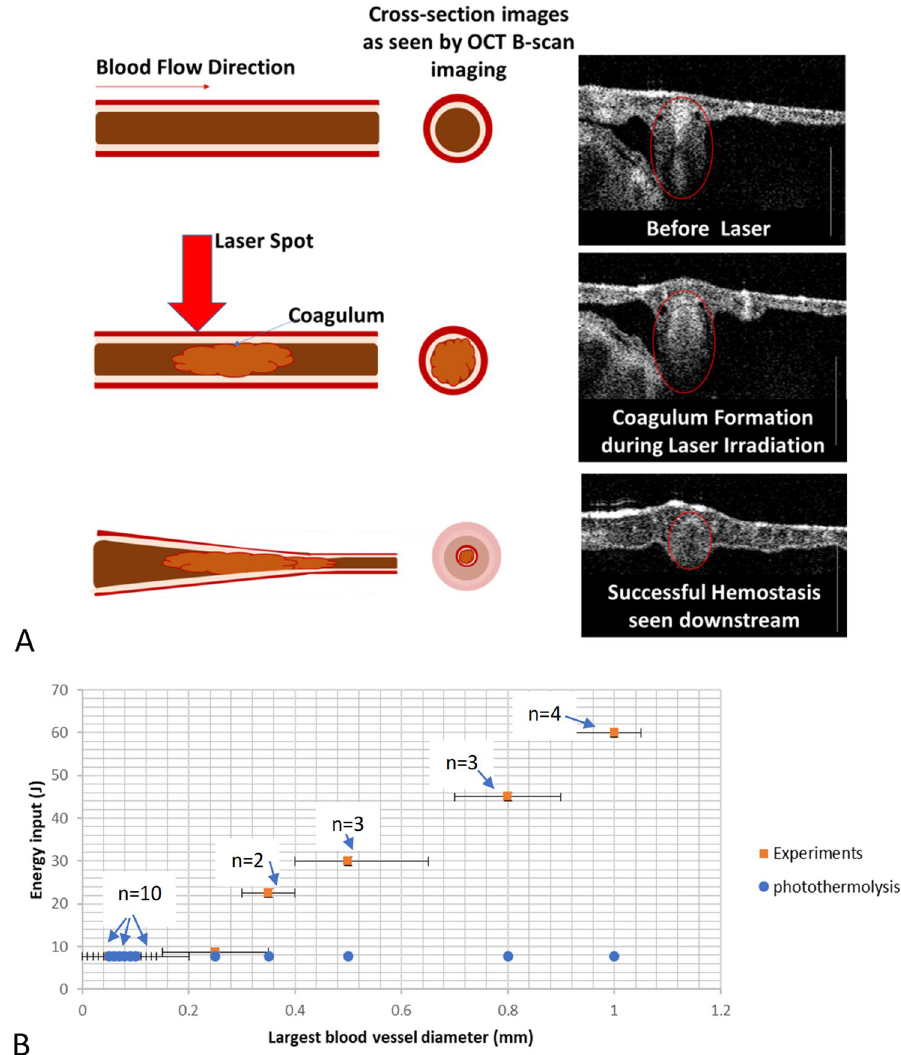
Figure 4. ( A ) Cross-sectional OCT monitoring of laser (1.07 µm) irradiation of CAM blood vessels. Downstream imaging across a blood vessel shows initial formation of the coagulum during laser irradiation, and after successful hemostasis, the blood vessel collapses downstream with no observable flow. Scale bar is 500 µm. ( B ) Radiant pulse energy (1.07 µm) determination with increasing blood vessel diameter in CAM arterioles for a 3 mm spot size. The number of trials at each vessel diameter is highlighted in the image with an ‘n’ number of trials/eggs. Blue circles indicate pulse energy computed from the theory of selective pulsed